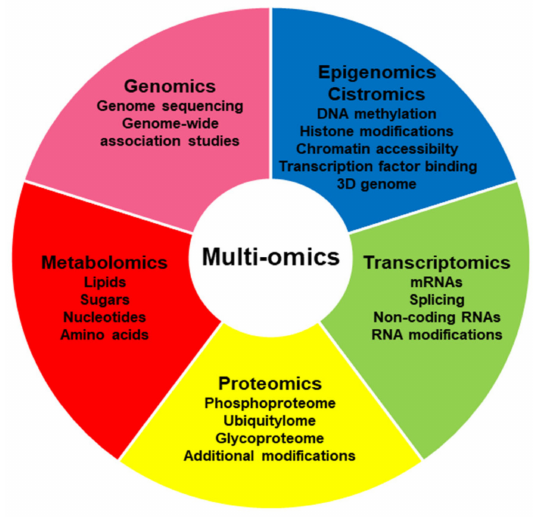
Figure 1. Overview of omics